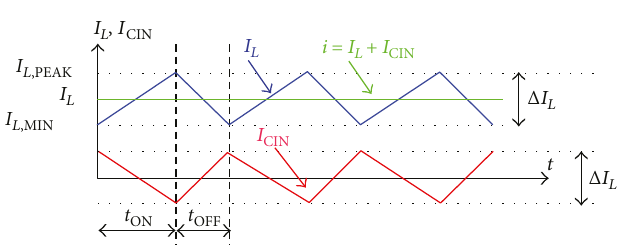
Figure 17: Current waveforms of the input capacitor and inductor in CCM.